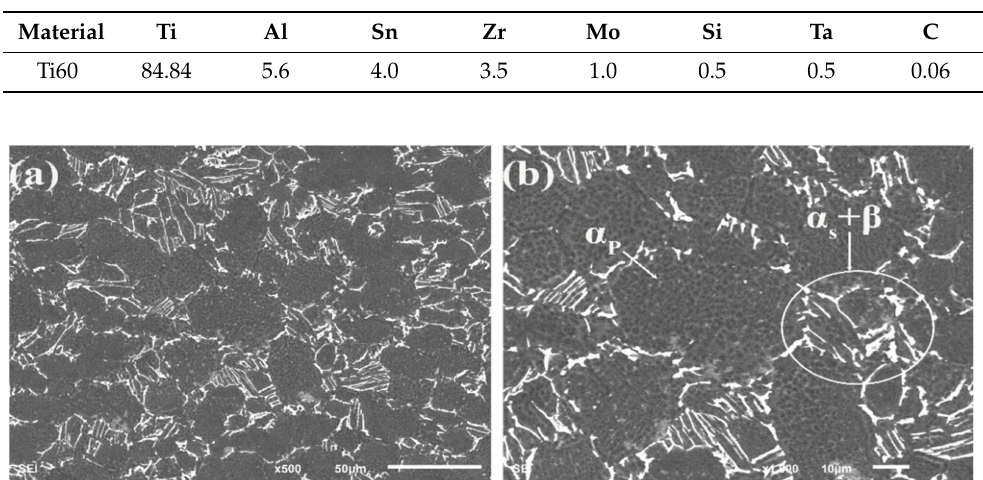
Table 1. Chemical composition (wt. %).